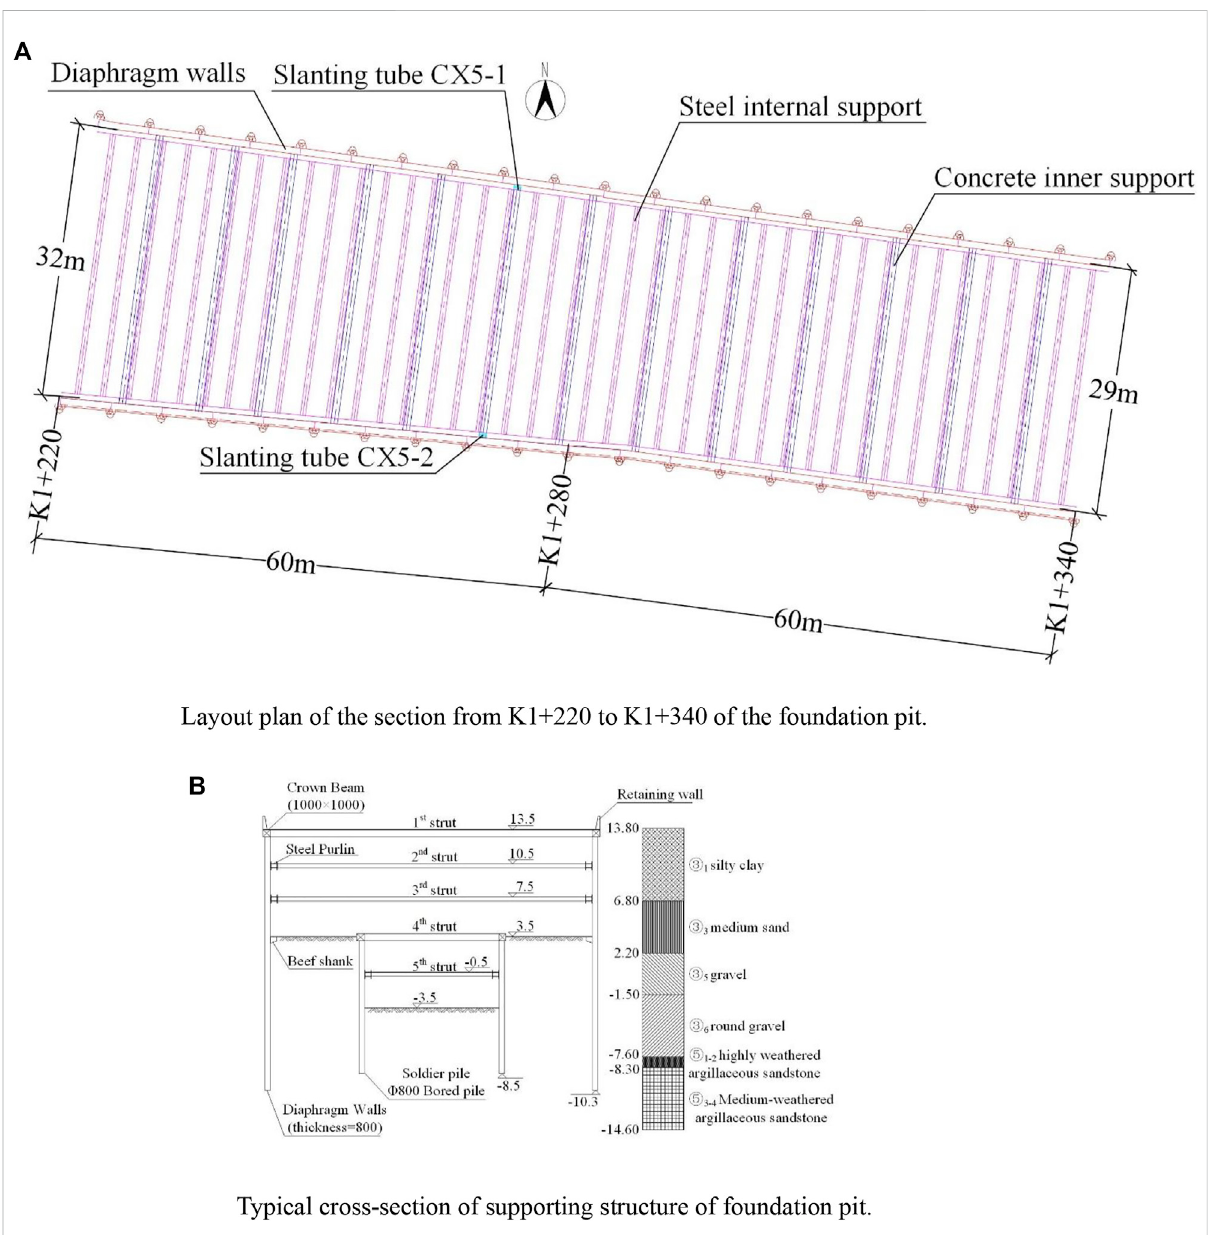
FIGURE 2 Analysis of selected pit project pro fi le. (A) Layout plan of the section from K1+220 to K1+340 of the foundation pit. (B) Typical cross-section of supporting structure of foundation